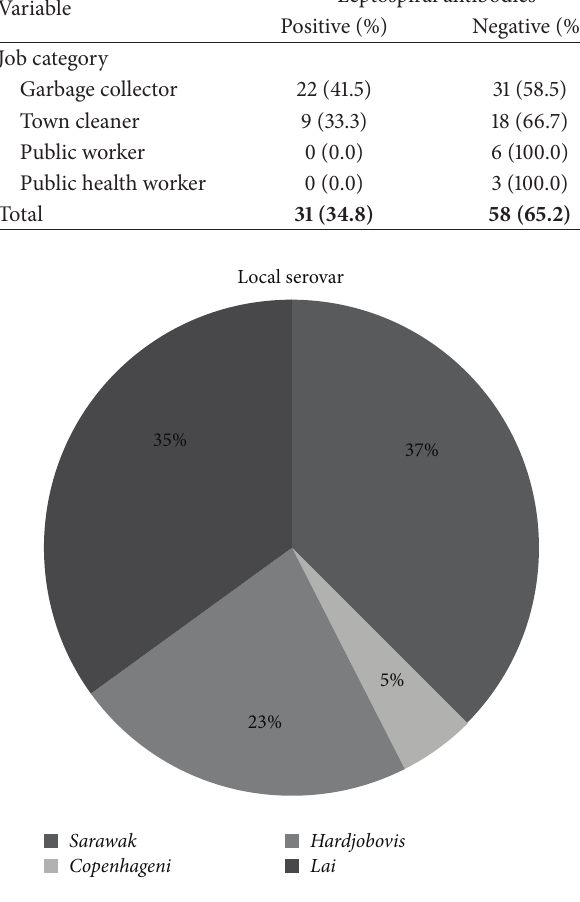
Figure 1: Serovar (local) among seropositive municipal service